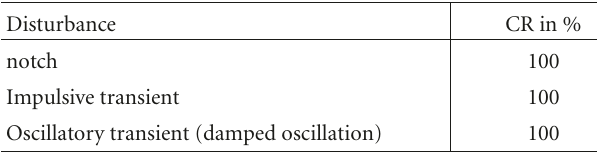
Table 3: Performance of the proposed technique for disturbance classification in the vector u when N = 1024 is considered.